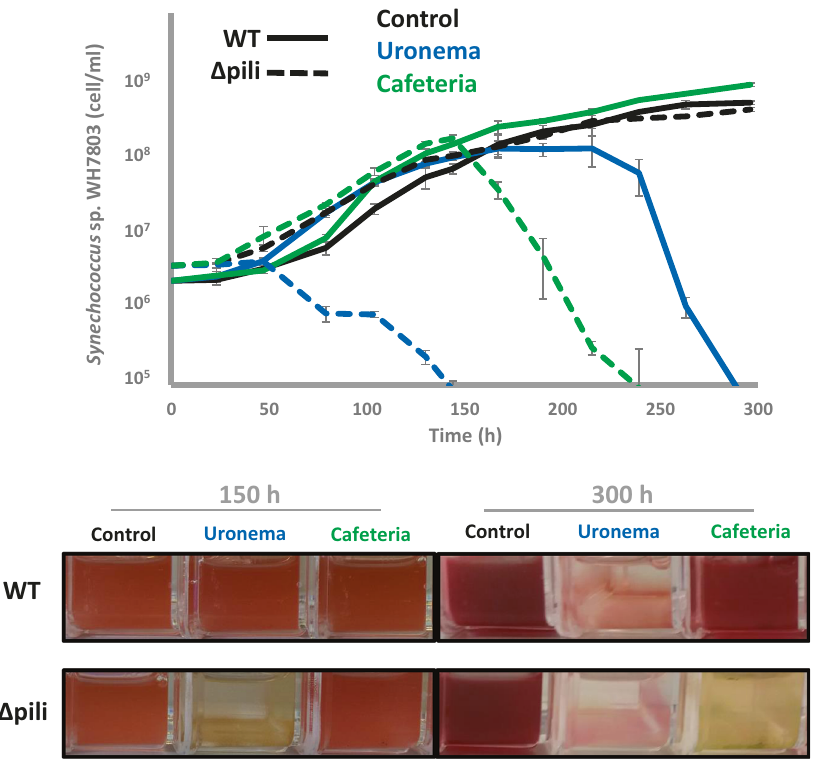
Fig. 5 Pili confer resistance to grazing. Growth curves (top panel) and culture images (bottom panel) of wild-type (WT; solid lines) and pili mutant ( Δ pili; dashed lines) cultures of Synechococcus sp. WH7803 incubated in the absence (control; black lines) and presence of two different grazers i.e . Uronema (blue lines) and Cafeteria (green lines). Cultures were subjected to constant shaking to keep the wild-type and pili mutant in planktonic form. Data are presented as mean values ± standard deviation from three culture replicates. Images represent one of three culture